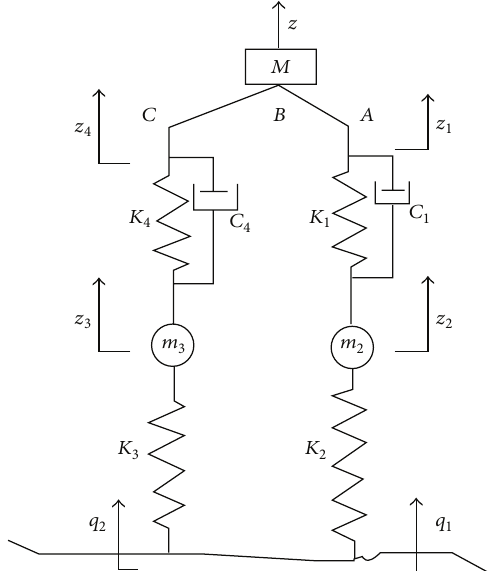
Figure 12: Plane model of the wheel-tracked exploration robot. sprung mass and unsprung mass, it is regarded as a massless rod. Suppose 𝑞 1 (𝑡) and 𝑞 2 (𝑡) represent the pavement rough- ness functions of front wheel and rear wheel, respectively.